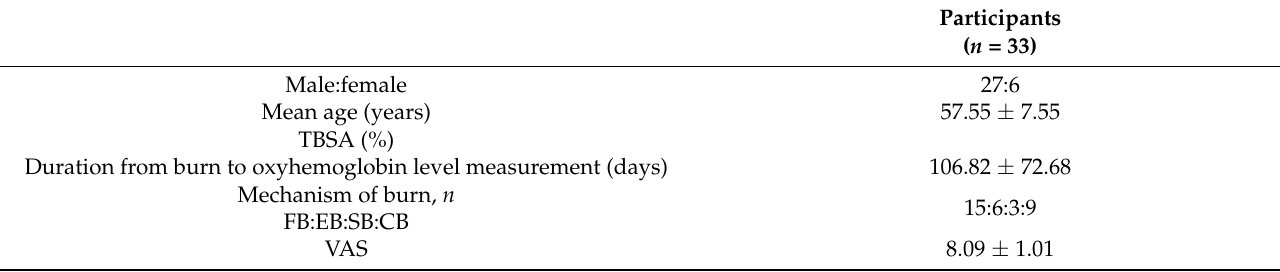
Table 1. Basic characteristics of the study